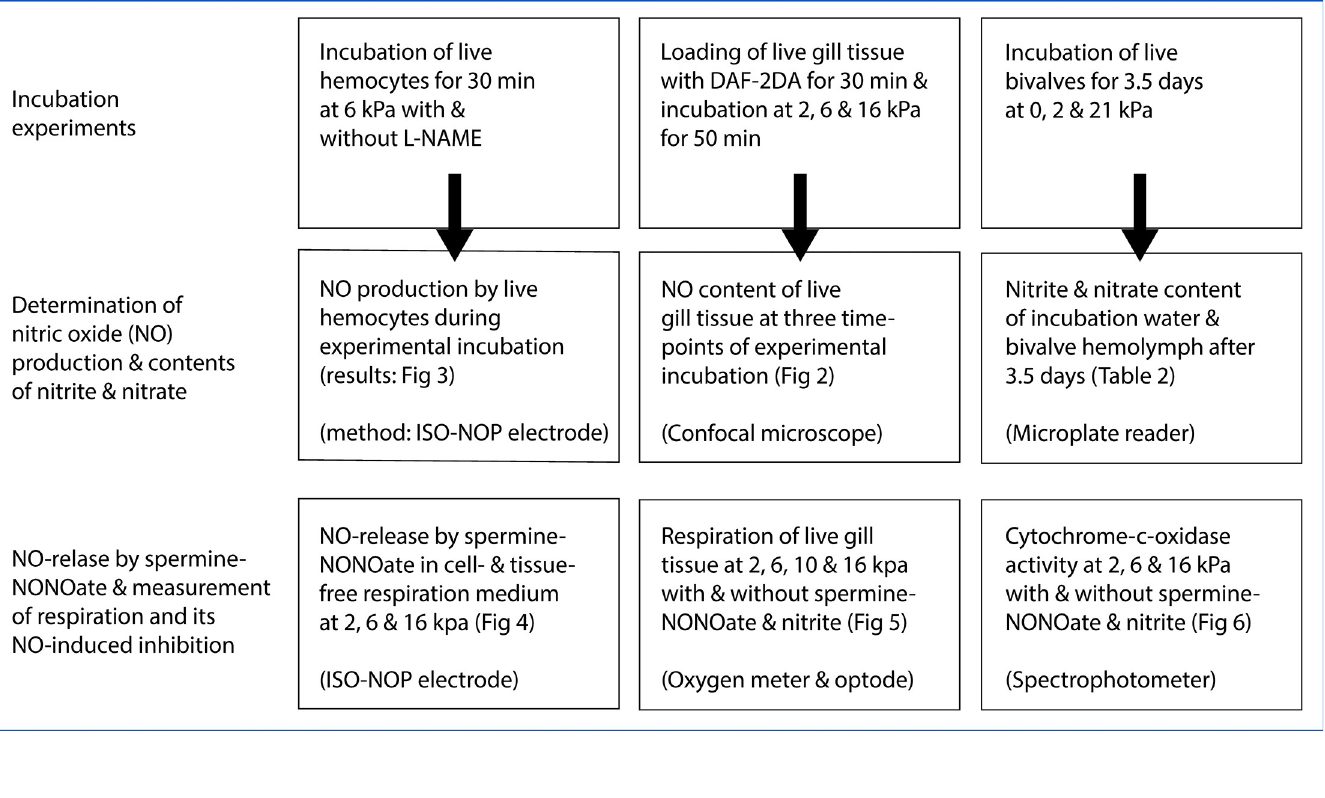
Fig 1. Overview of incubation experiments and laboratory